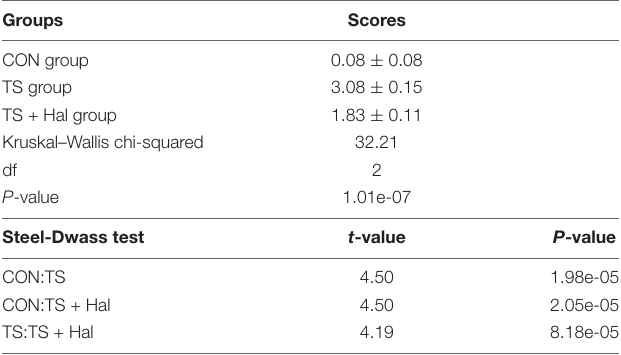
TABLE 1 | Comparison of scores of behavior assessment in each group.